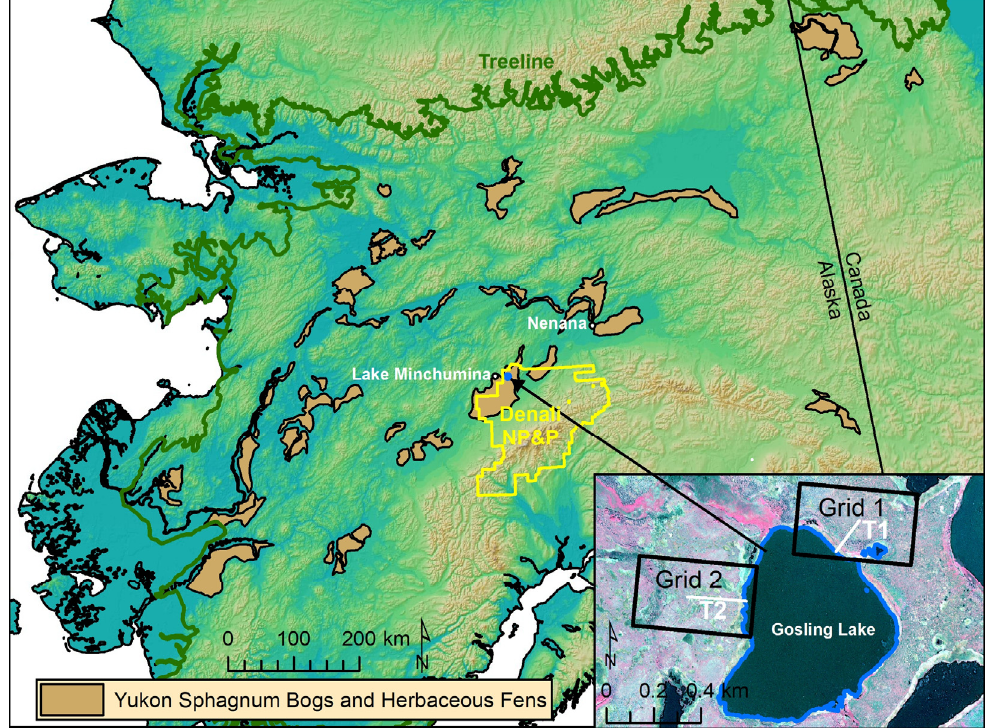
Figure 1. Map of the study area at Gosling Lake in northwestern Denali National Park and Preserve in relation to major permafrost-affected peatlands with Sphagnum bog and herbaceous fen vegetation in the Alaska–Yukon floristic province [11]. Inset shows the locations of remote-sensing grids ( black ) and field survey transects T1 and T2 ( white ).